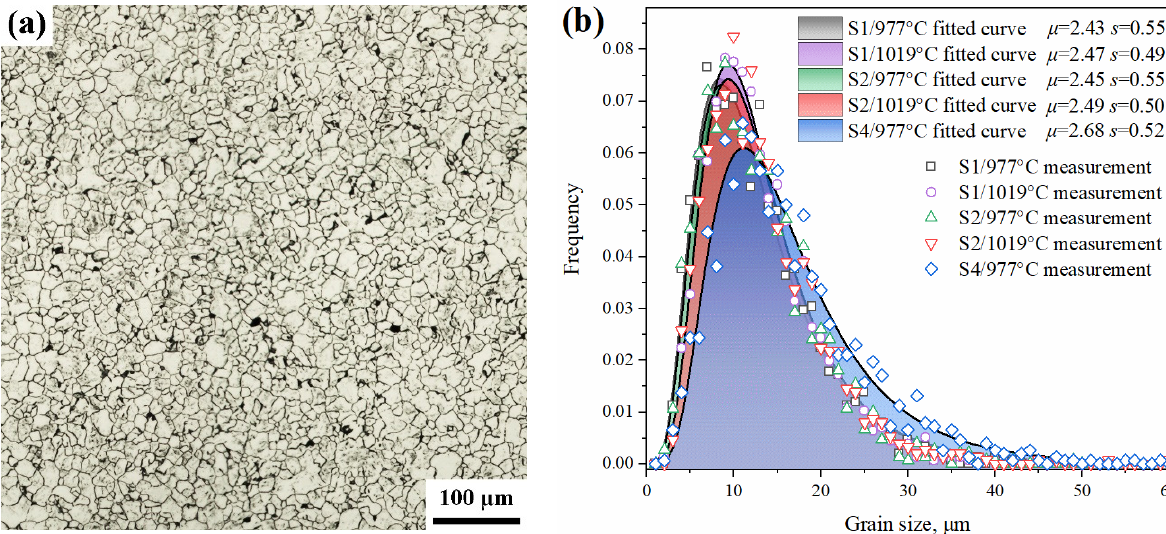
Figure 2. ( a ) Prior austenite grain structure (PAGS) after holding 300 s at 977 °C of S2; ( b ) Grain size-frequency distributions after holding 300 s at various temperatures of S1, S2, and S4.